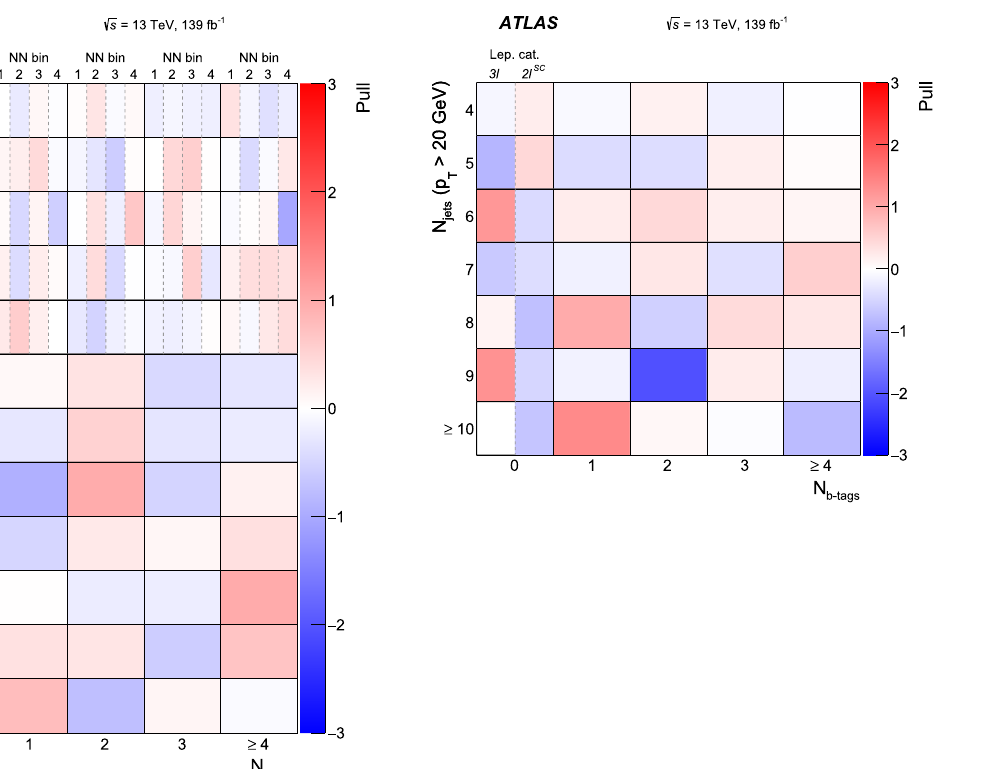
total uncertainty. The total uncertainty is the sum in quadrature of the statistical error of the observed data and the uncertainty in the predicted